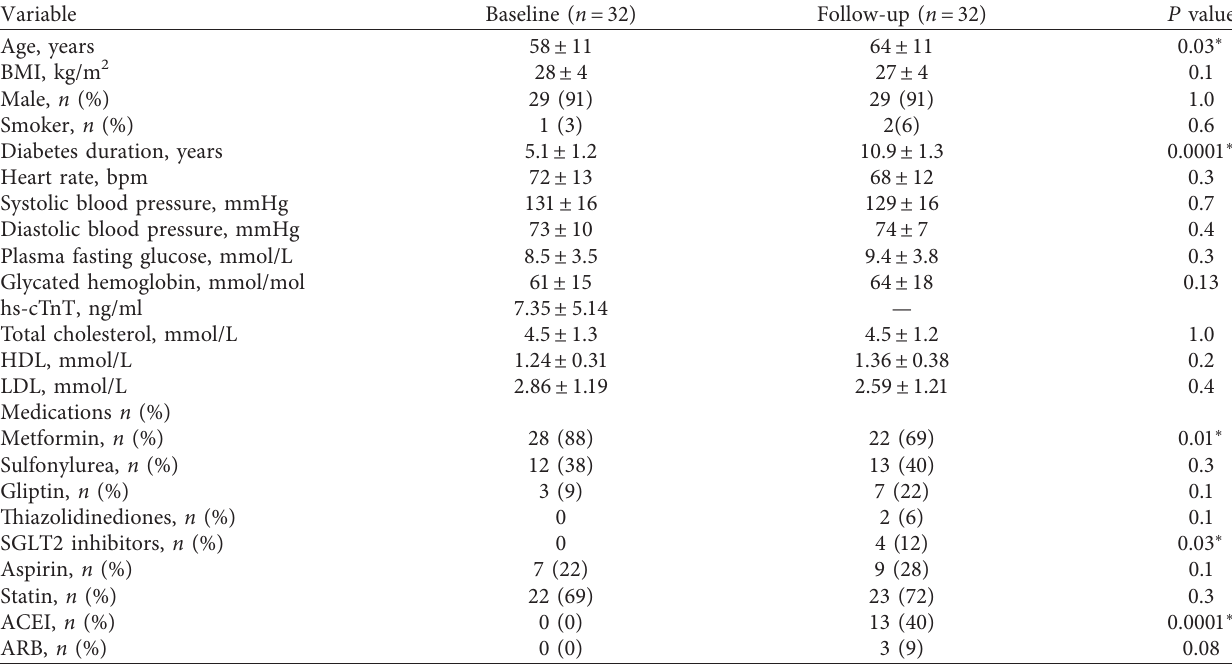
Figure 3: Major adverse cardiovascular event rates. The major adverse cardiovascular event rate (MI, angina, revascularization, CVA, and death) during the 6-year follow-up period, including the patients with a silent MI, amounted to 25% in this study with an overall clinical event rate of 35%. Table 2: Clinical and biochemical characteristics of the participants who had baseline and year 6 follow-up CMR